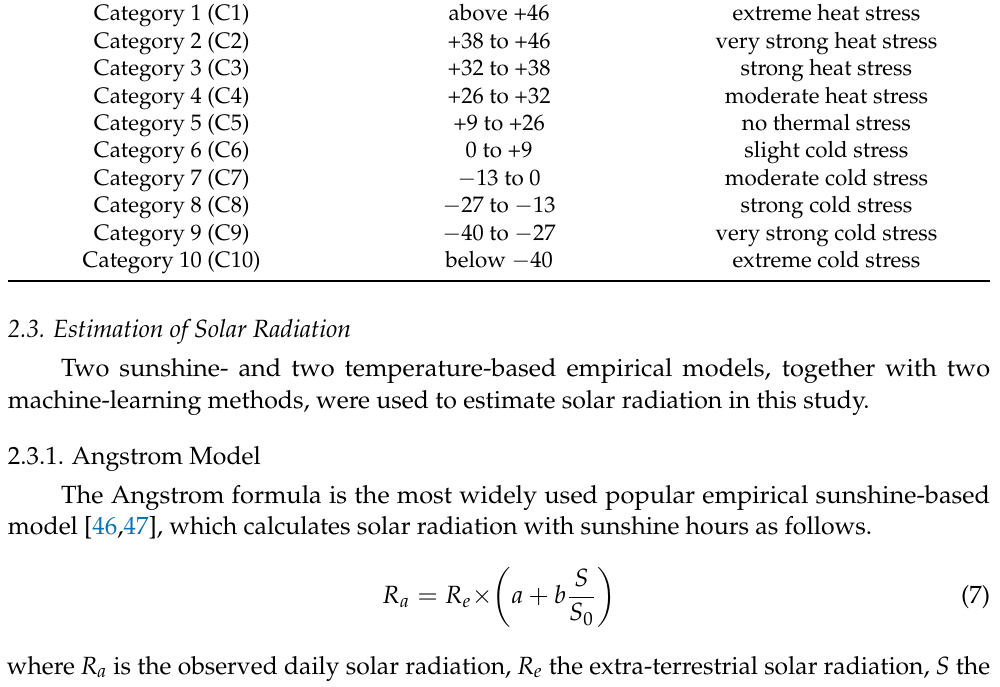
Table 2. Category for UTCI in terms of thermal stress (according to Brode et al. [16]). Category UTCI Range ( ◦ C) Stress